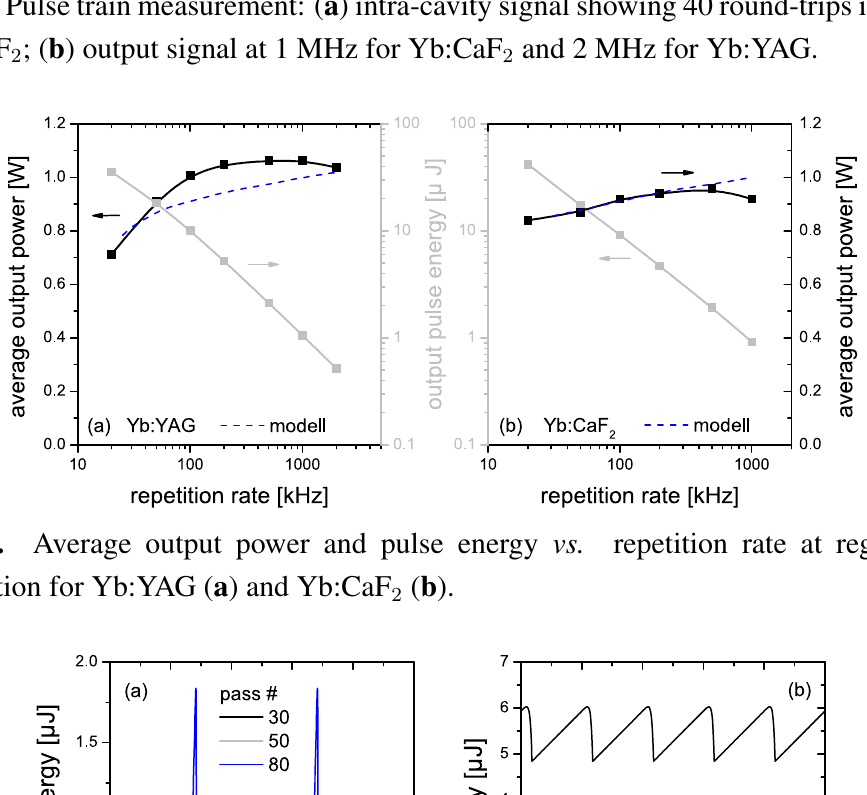
and 2 MHz for Yb:YAG. 2